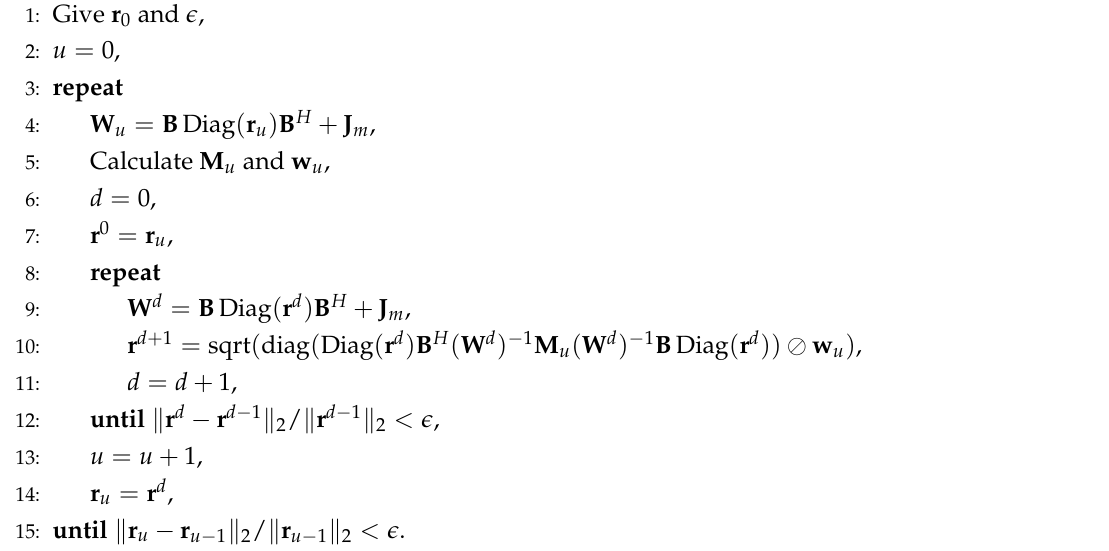
Algorithm 2 The MM1-SPICE algorithm for spatially non-uniform white